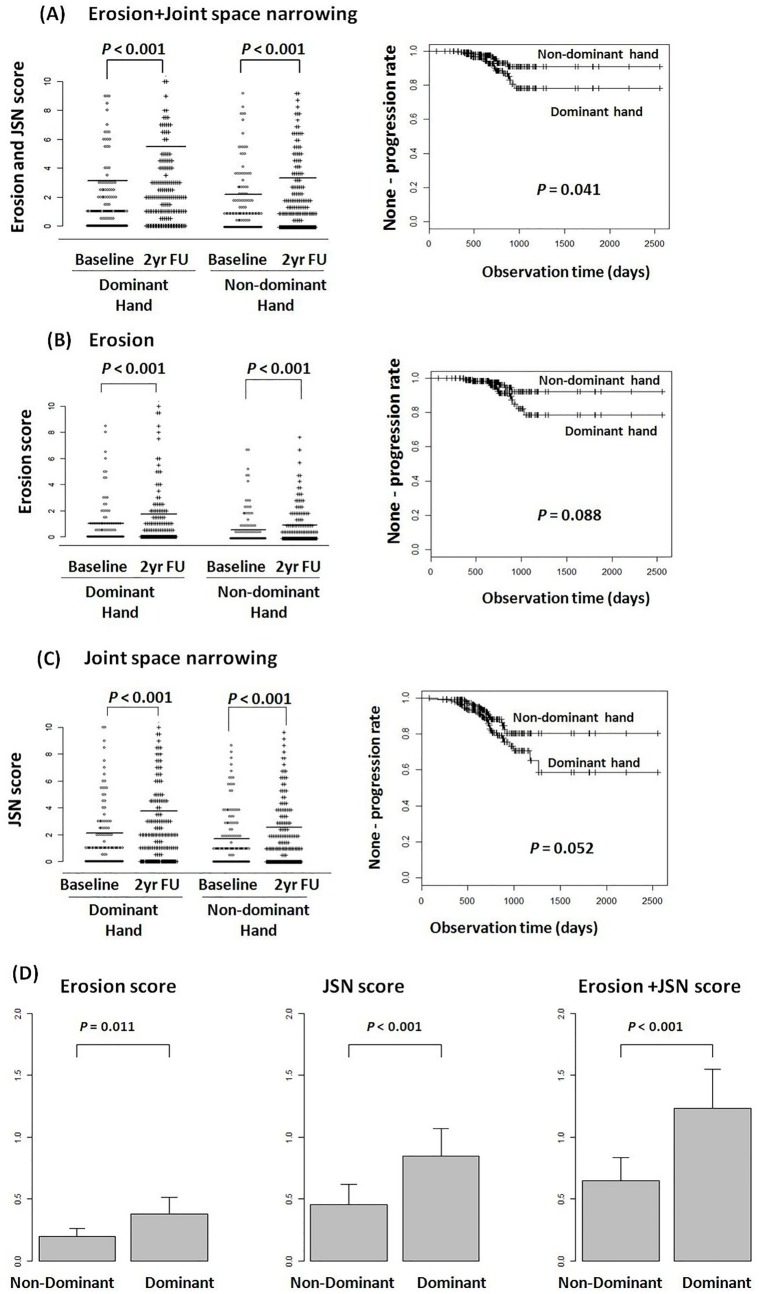
Hand total, erosion and joint space narrowing (JSN) van der Heijde modified Sharp scores (HSS) at baseline and at 2-year follow-up, time-to-radiographic progression and annual progression according to handedness.Radiographic progression was defined as a change in the erosive or JSN HSS ≥ 1.5 and a total HSS ≥ 3 in both hands during the follow-up period. (A) Baseline and follow-up total HSS were significantly higher in the dominant hand than in the non-dominant hand. The Log-rank test identified a significant difference in overall progression between the dominant and non-dominant hand (P = 0.041). (B and C) Baseline and follow-up erosion and JSN score were significantly higher in the dominant hand than in the non-dominant hand. The overall erosion and JSN progression rates were 5.7% and 7.5% respectively, during the 2-year follow period. (D) Annual progression of erosion, JSN, and both, were more rapid in the dominant hand.